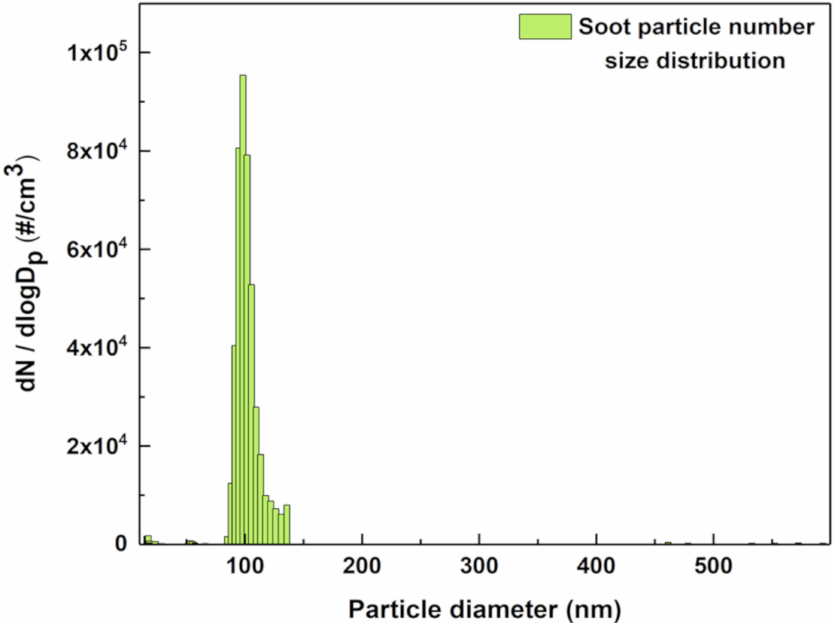
Figure 4. Size distribution of the 100 nm size selected soot particles monitored using the reference Di ff erential Mobility Analyser and Condensation Particle